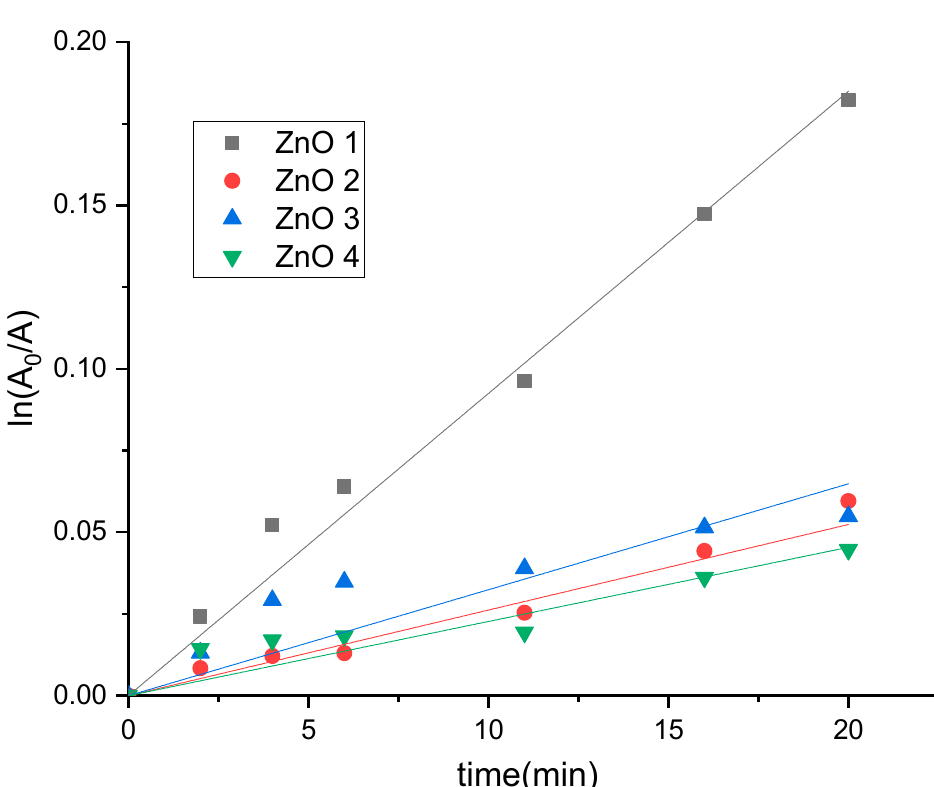
Figure 10. First-order kinetics plot of ln( A 0 / A ) versus irradiation time for photocatalytic degradation of methylene blue under visible over different ZnO synthesized samples.